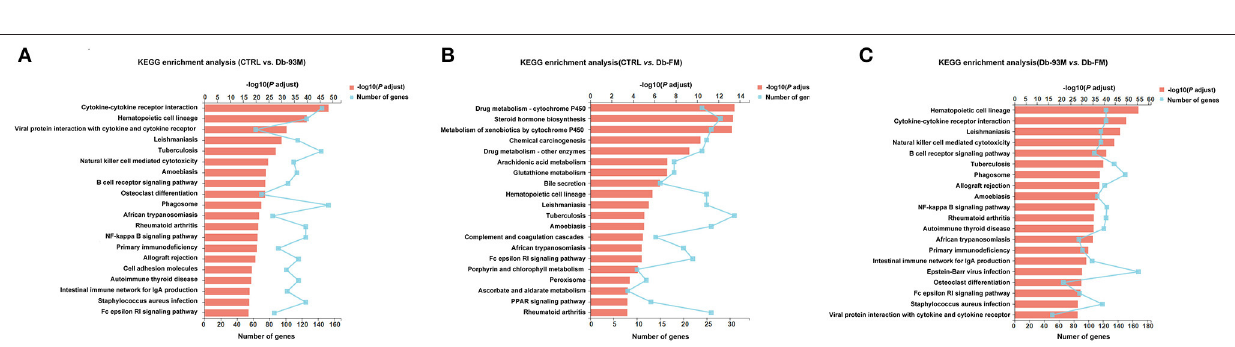
a similar trend, which was overactivated in Db-93M,